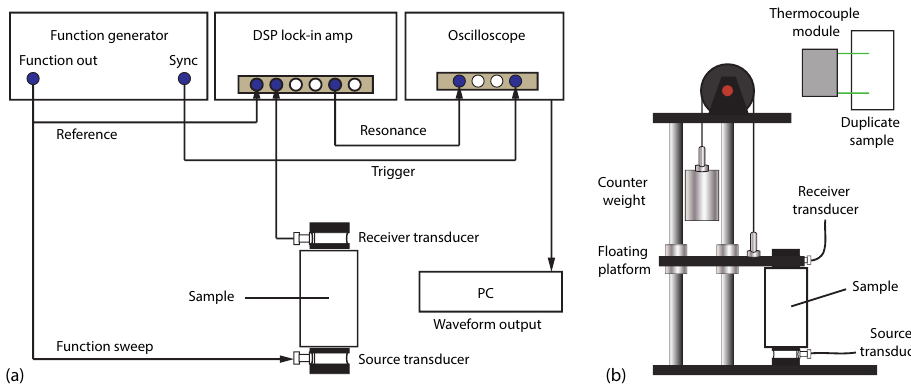
Figure 2. Diagram of the RUS set-up (a) and of the load-minimizing sample frame with temperature monitoring equipment (b) .